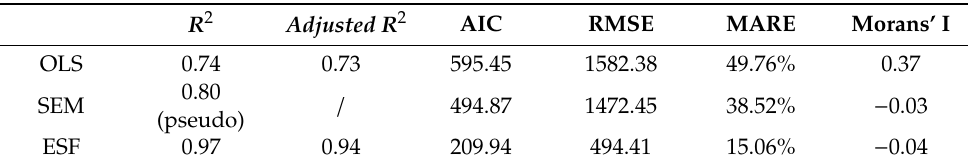
Table A1. Model performance without NTL variable in